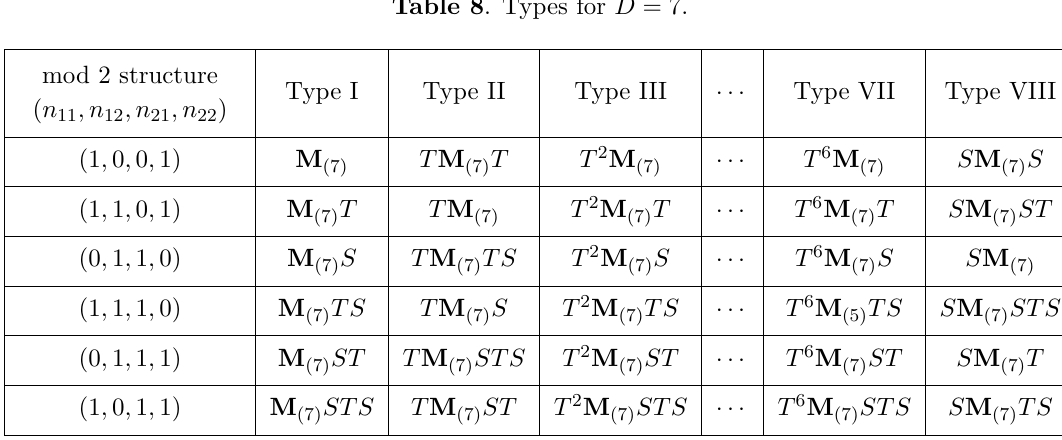
Table 9 . Classification by the mod 2 structure for D = 7